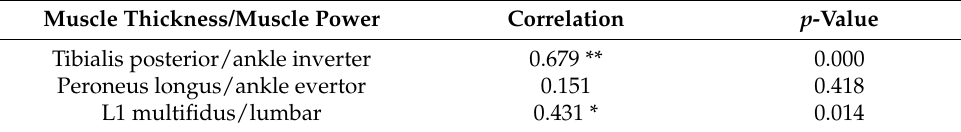
Table 4. Correlation between muscle strength and muscle thickness for all participants (n = 16).